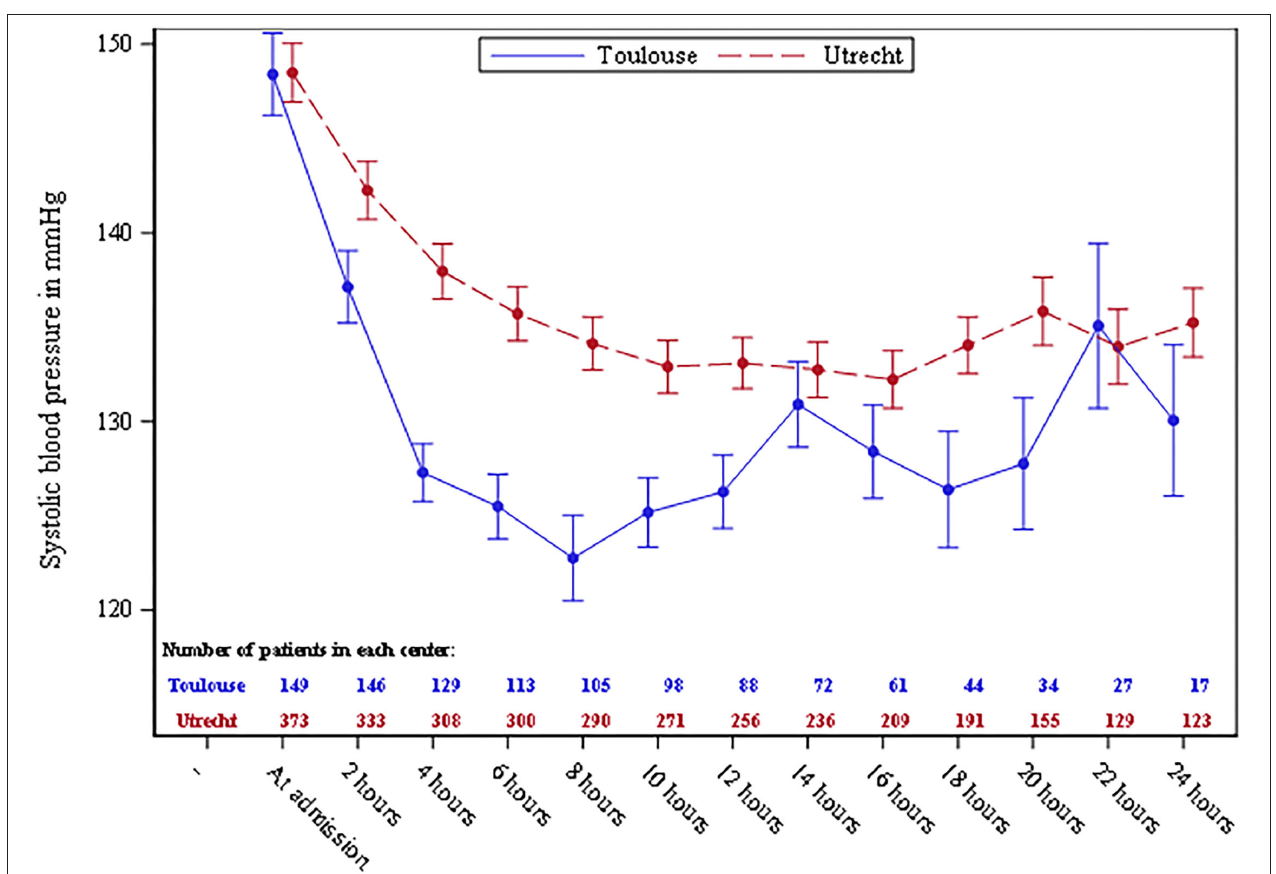
FIGURE 1 | Systolic blood pressure (mmHg) distribution among the two centers during the first 24h after admission. Plot means with standard error bars. The patients are censored after aneurysm treatment or